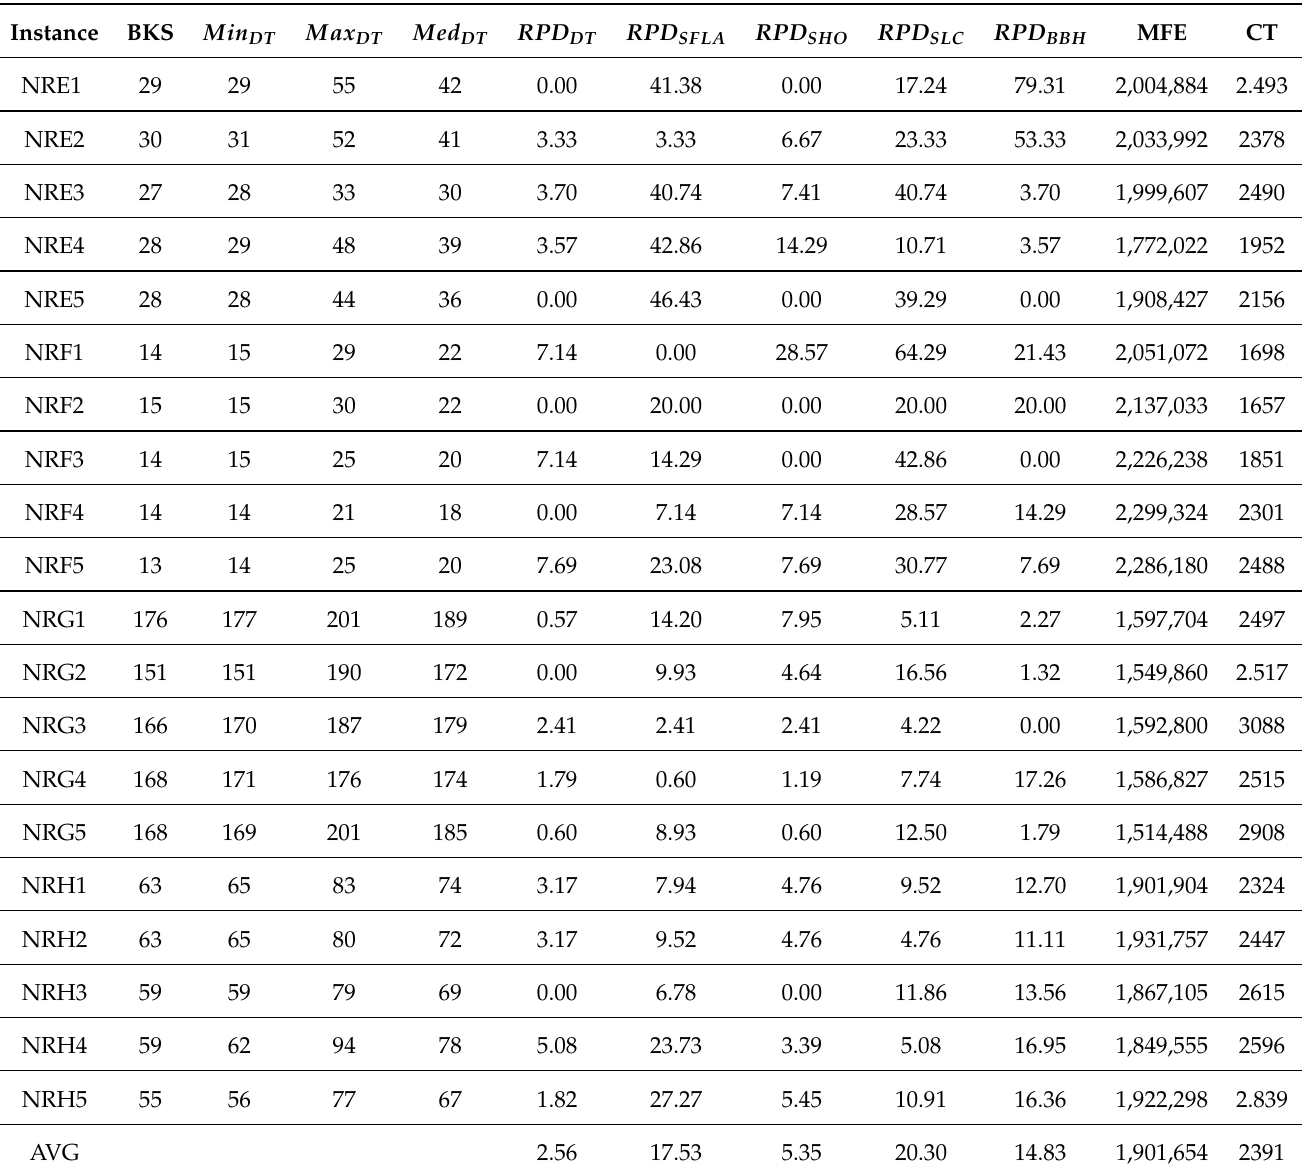
Table 4. 2K nodes RPD comparison for standalone and distributed